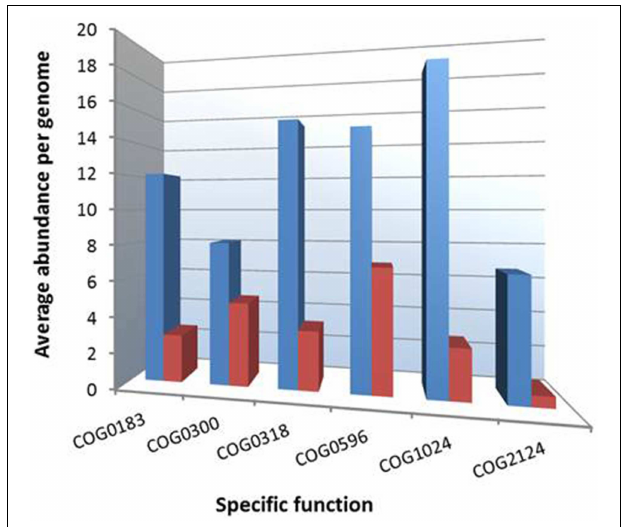
FIGURE 4 | Overrepresentation of specific COGs among genomes of presumed K -strategists within the proposed order Cellvibrionales . Blue and red bars symbolize the average abundance of specific COG categories in the genomes of 17 K -selected and nine r -selected strains, respectively. The function of the indicated COGs is as follows: COG0183, acetyl-CoA acetyltransferase; COG0300, short-chain dehydrogenases of various substrate specificities; COG0318, acyl-CoA synthetases (AMP-forming)/AMP-acid ligases II; COG0596, predicted hydrolases or acyltransferases (alpha/beta hydrolase superfamily); COG1024, enoyl-CoA hydratase/carnithine racemase; COG2124, cytochrome